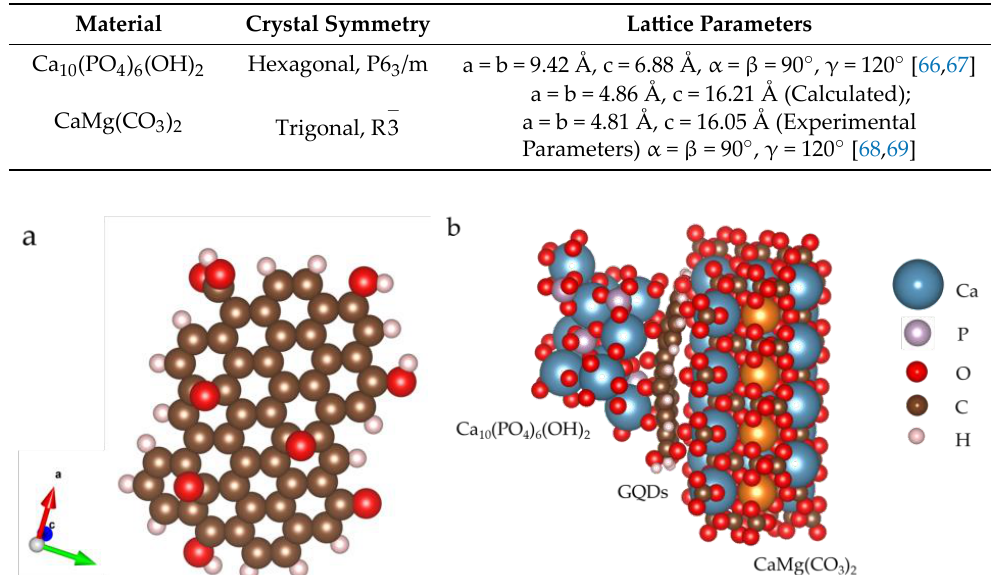
Table 2. Crystal Structures of HAP and dolomite.